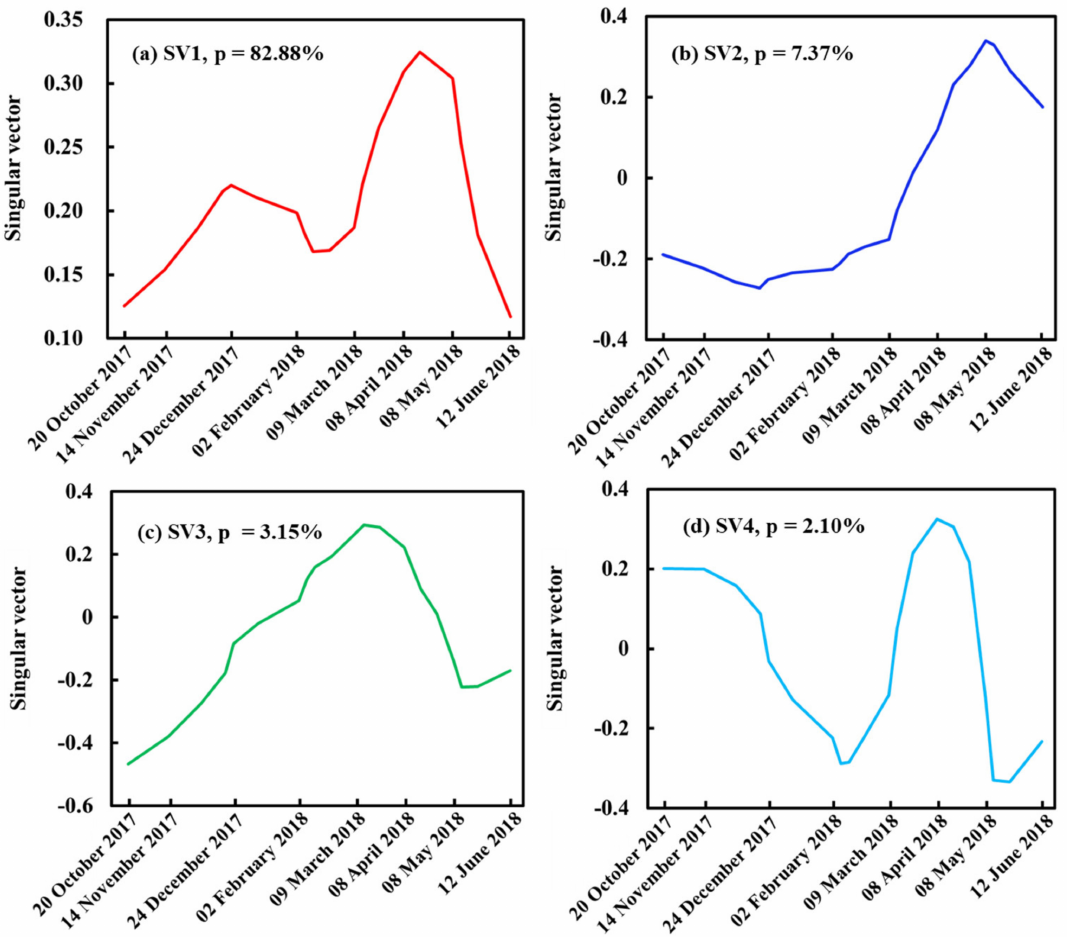
Figure 5. The first four singular vectors (SVs) derived from the winter wheat NDVI time series training set of Puyang County. The percentages in the figures represent the relative amount of information captured by each